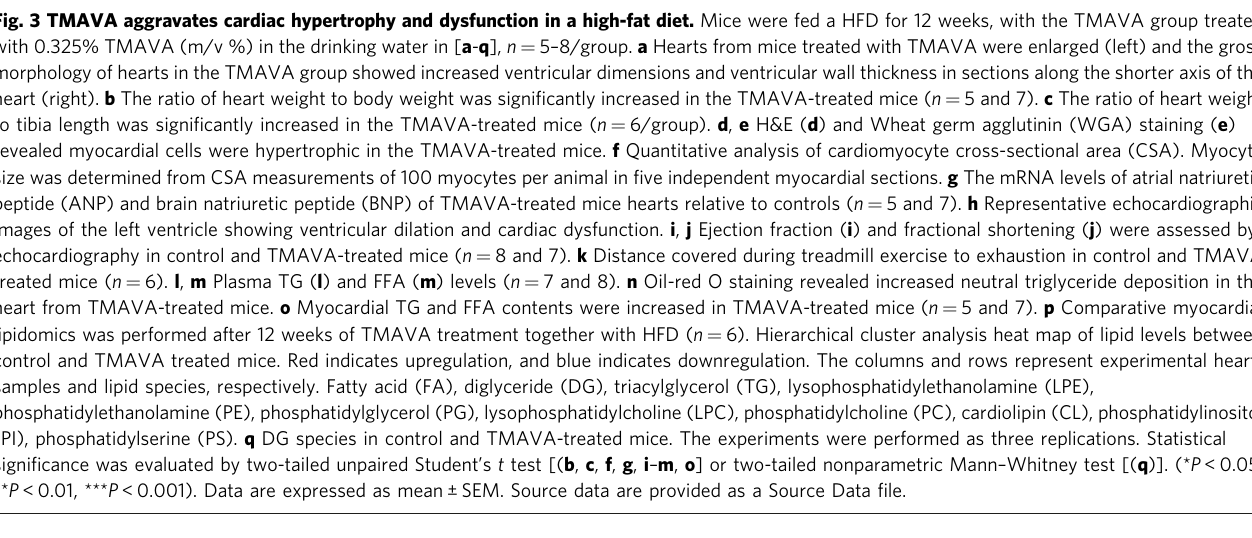
Fig. 3 TMAVA aggravates cardiac hypertrophy and dysfunction in a high-fat diet. Mice were fed a HFD for 12 weeks, with the TMAVA group treated with 0.325% TMAVA (m/v %) in the drinking water in [ a - q ], n = 5 – 8/group. a Hearts from mice treated with TMAVA were enlarged (left) and the gross morphology of hearts in the TMAVA group showed increased ventricular dimensions and ventricular wall thickness in sections along the shorter axis of the heart (right). b The ratio of heart weight to body weight was signi fi cantly increased in the TMAVA-treated mice ( n = 5 and 7). c The ratio of heart weight to tibia length was signi fi cantly increased in the TMAVA-treated mice ( n = 6/group). d , e H&E ( d ) and Wheat germ agglutinin (WGA) staining ( e ) revealed myocardial cells were hypertrophic in the TMAVA-treated mice. f Quantitative analysis of cardiomyocyte cross-sectional area (CSA). Myocyte size was determined from CSA measurements of 100 myocytes per animal in fi ve independent myocardial sections. g The mRNA levels of atrial natriuretic peptide (ANP) and brain natriuretic peptide (BNP) of TMAVA-treated mice hearts relative to controls ( n = 5 and 7). h Representative echocardiographic images of the left ventricle showing ventricular dilation and cardiac dysfunction. i , j Ejection fraction ( i ) and fractional shortening ( j ) were assessed by echocardiography in control and TMAVA-treated mice ( n = 8 and 7). k Distance covered during treadmill exercise to exhaustion in control and TMAVA treated mice ( n = 6). l , m Plasma TG ( l ) and FFA ( m ) levels ( n = 7 and 8). n Oil-red O staining revealed increased neutral triglyceride deposition in the heart from TMAVA-treated mice. o Myocardial TG and FFA contents were increased in TMAVA-treated mice ( n = 5 and 7). p Comparative myocardial lipidomics was performed after 12 weeks of TMAVA treatment together with HFD ( n = 6). Hierarchical cluster analysis heat map of lipid levels between control and TMAVA treated mice. Red indicates upregulation, and blue indicates downregulation. The columns and rows represent experimental heart samples and lipid species, respectively. Fatty acid (FA), diglyceride (DG), triacylglycerol (TG), lysophosphatidylethanolamine